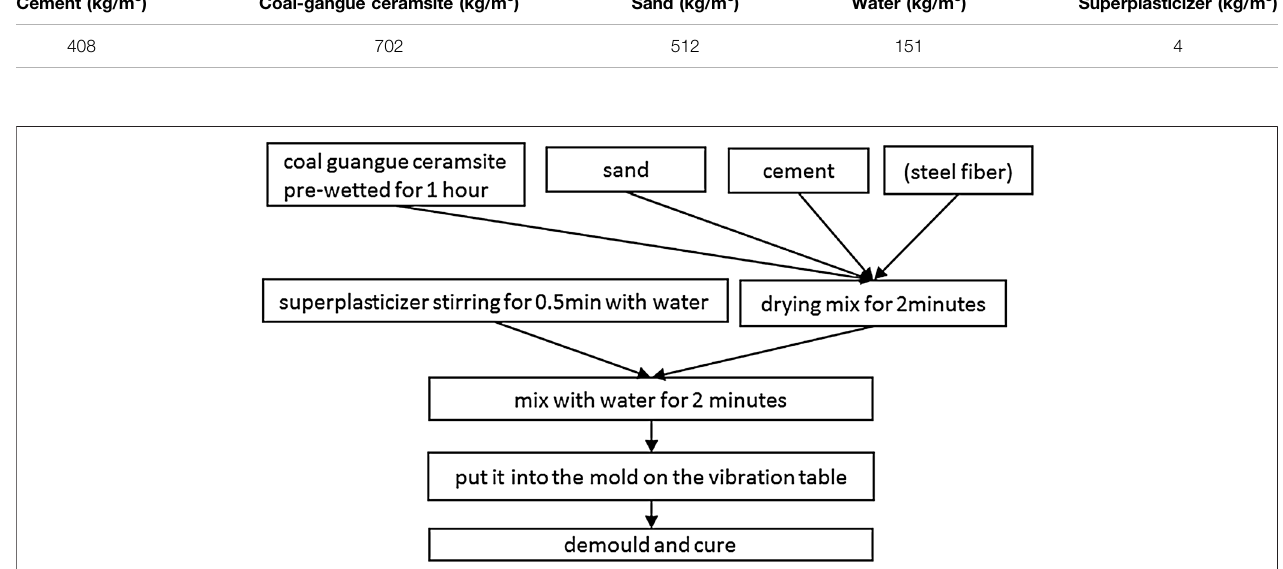
FIGURE 2 | Production procedure of coal-gangue ceramsite lightweight aggregate concrete (CGCLWAC).